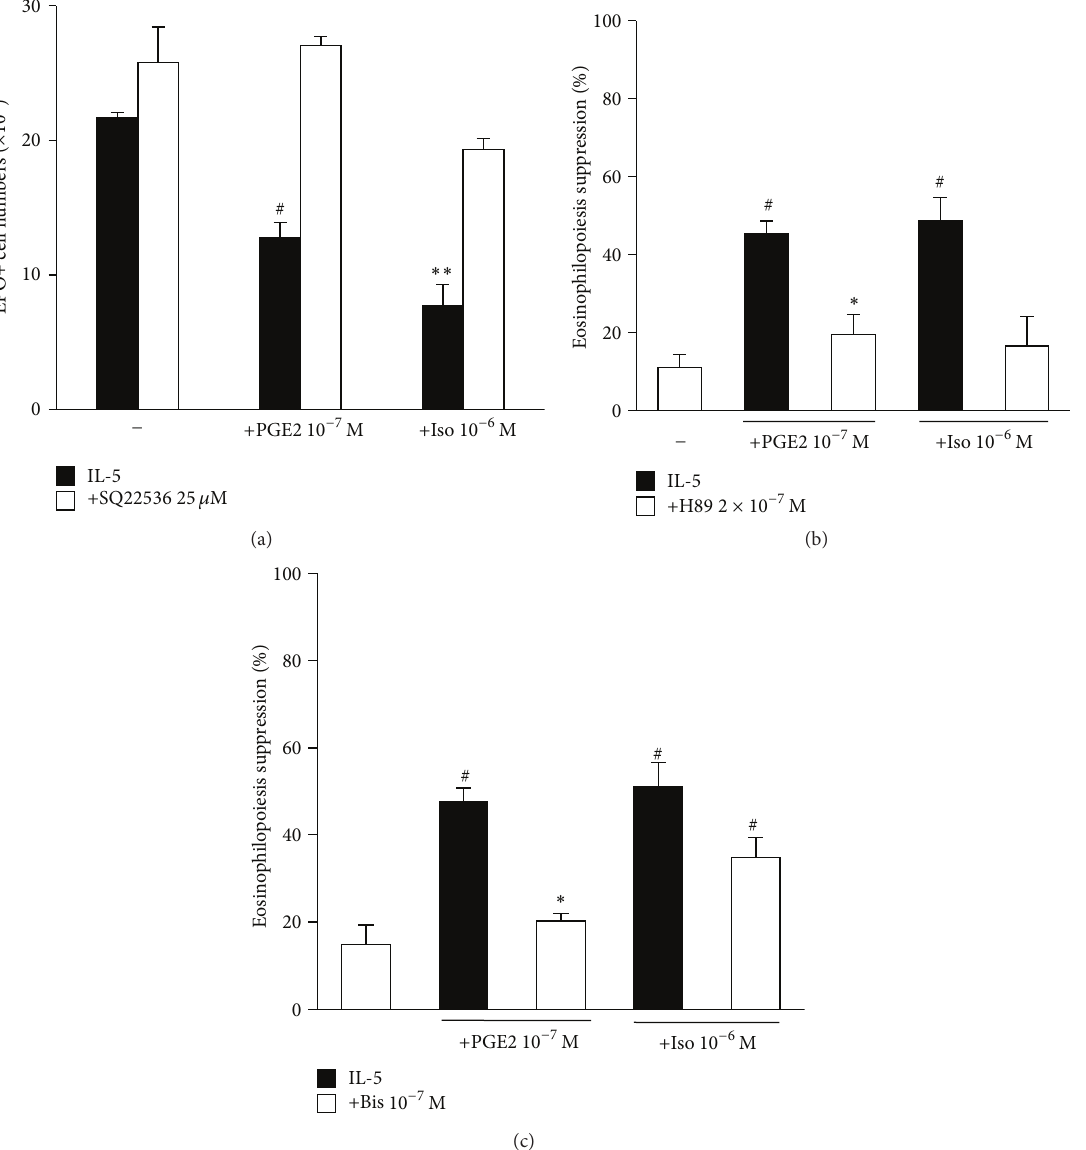
Figure 4: Isoproterenol and PGE2 share intracellular signaling mechanisms. Bone-marrow cultures were established in the presence of IL-5, alone or associated with adenylate cyclase inhibitor SQ22536 (a), PKA selective inhibitor H89 (b), PKC/PKA dual inhibitor Bis (c), or the indicated combinations of these agents, which were all present from the beginning of culture for a 7-day period. Data (mean + SEM; 𝑛 = 4 ) are the numbers of EPO+ cells recovered at the end of the culture (a) or the % eosinophilopoiesis suppression in the indicated conditions, where inhibitors were used to prevent this suppression ((b) and (c)). Significant differences relative to the respective IL-5 controls: ∗ 𝑃 ≤ 0.05 , ∗∗ 𝑃 ≤ 0.01 , § 𝑃 ≤ 0.005 , # 𝑃 ≤ 0.0025